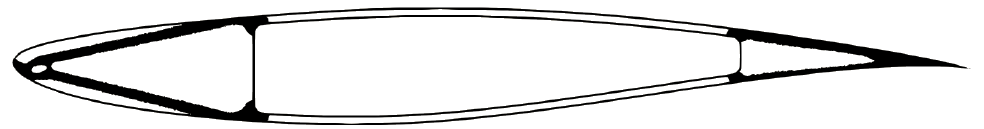
Figure 17. Topologically optimized structure for case